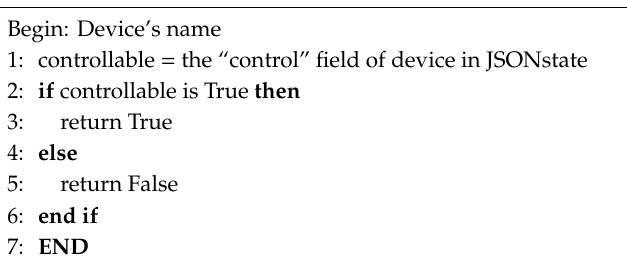
Algorithm 1. Device’s Controllable